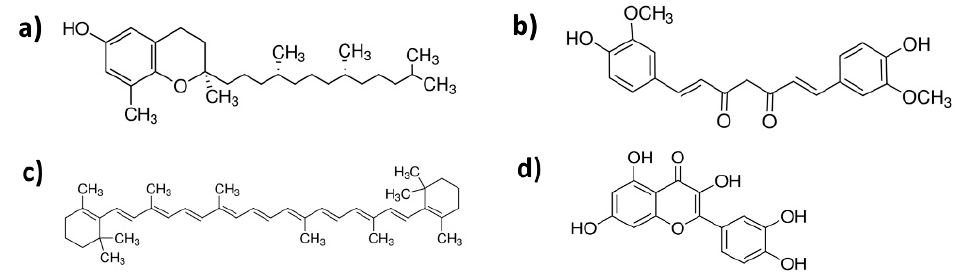
Figure 1. Structures of natural additives employed in this research: ( a ) δ -tocopherol ( δ -TF), ( b ) curcumin (CM), ( c ) β -carotene ( β -CT), ( d ) quercetin (QU).